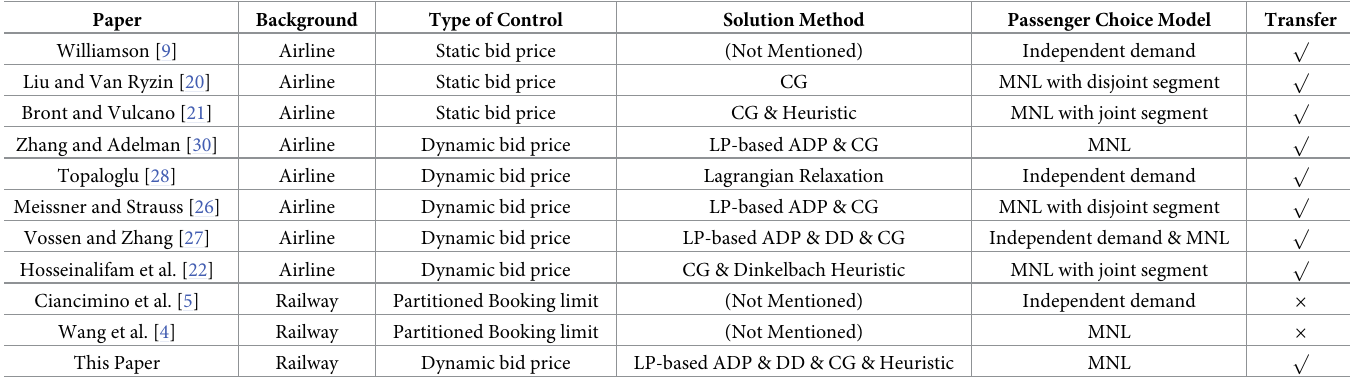
Table 1. Characteristics of various recent studies of seat inventory